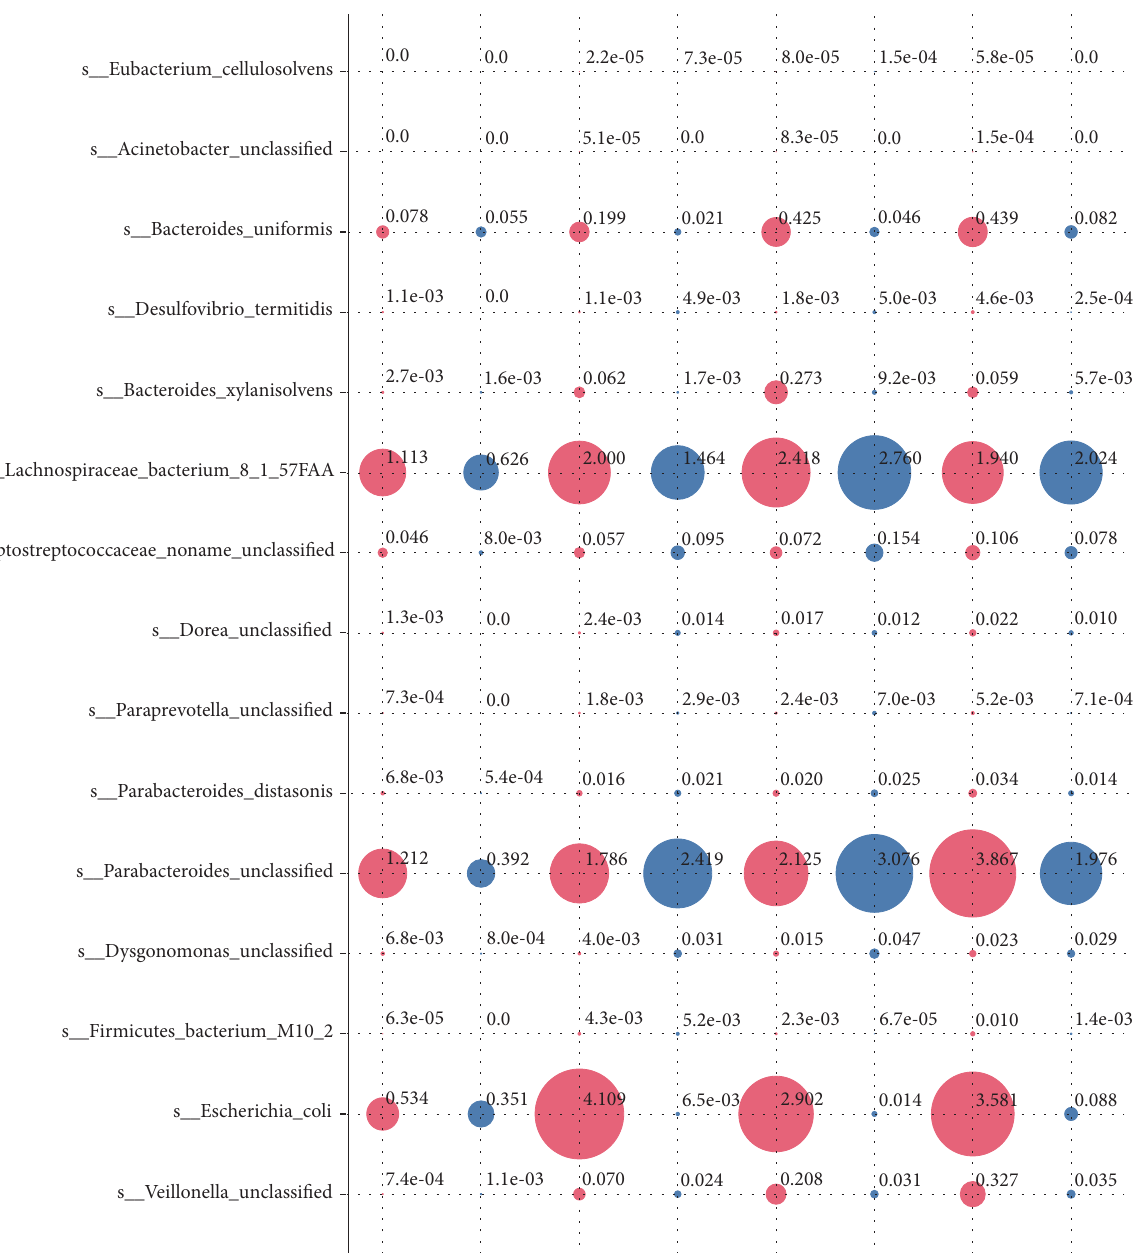
Figure 3: Significant differences in the gut microbiota species abundance between the OVX and control groups at different time points. This figure shows that the 15 gut microbiota species had significantly different abundance between the OVX and control groups at four time points. The abscissa shows different time points, and the ordinate shows 15 significantly different gut microbiota. This size of each point represents the relative abundance of the corresponding gut microbiota at a specific time point and by group. The numbers at the upper right corner of each point mark the relative abundance of the gut microbiota species represented by each point. The OVX group and the control group are colored red and blue,